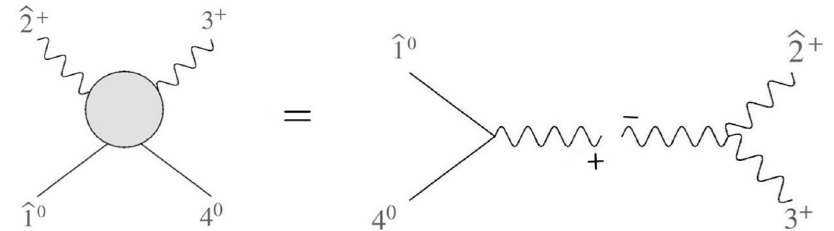
Figure 2 . Four-particle amplitude in scalar